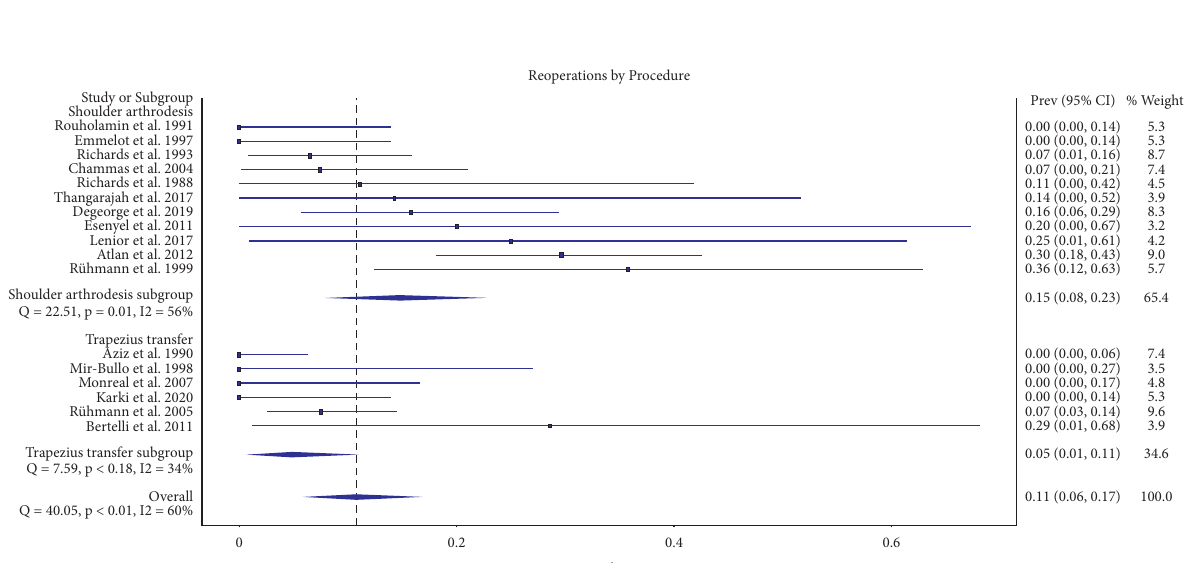
transfer subgroup Q = 7.59, p < 0.18, I2 = 34% Q = 40.05, p < 0.01, I2 = Figure 3: Forest plot illustrating the proportions of reoperations for shoulder arthrodesis versus upper trapezius